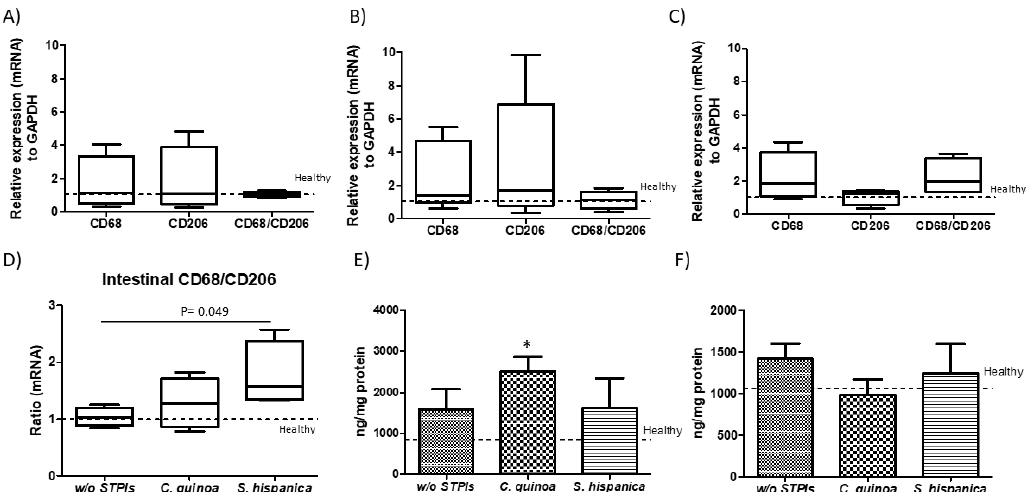
Figure 7. Immune mediators in duodenal sections from diethylnitrosamine (DEN) and thioacetamide (TAA)-treated mice compared to those administered with protease (serine-type) inhibitors (PIs) (100 µ g / animal). Duodenal relative expression (mRNA) of the macrophage transmembrane glycoprotein CD68 and mannose receptor CD206 in animals administered without ( A ) or with PIs from C. quinoa ( B ) and S. hispanica ( C ) and comparative CD68 / CD206 variations ( D ). Cytokine concentration: ( E ) Tumor necrosis factor (TNF)- α and ( F ) granulocyte-monocyte colony stimulating factor (GM-CSF). Results are expressed as mean ± SEM ( n = 4 − 6). *Indicates statistical differences (Tukey–Kramer’s test, p < 0.05) to DEN/TAA-treated animals not receiving PIs.